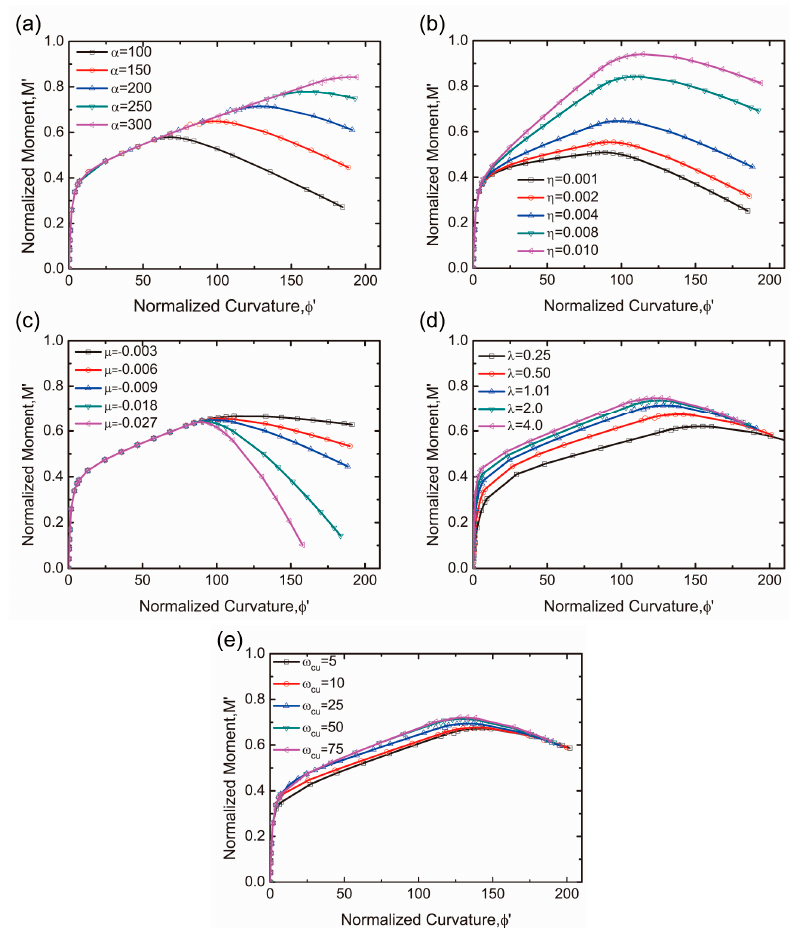
Figure 10. Parametric studies of the five material parameters on the normalized moment curvature response: ( a ) vary α ; ( b ) vary η ; ( c ) vary μ ; ( d ) vary λ and ( e ) vary ω cu